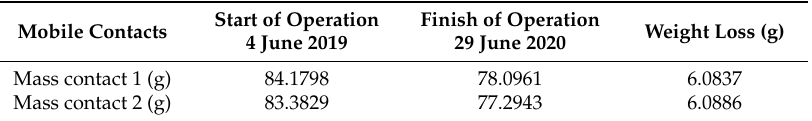
Table 6. Comparison of the masses of the voltage regulator’s mobile contacts.